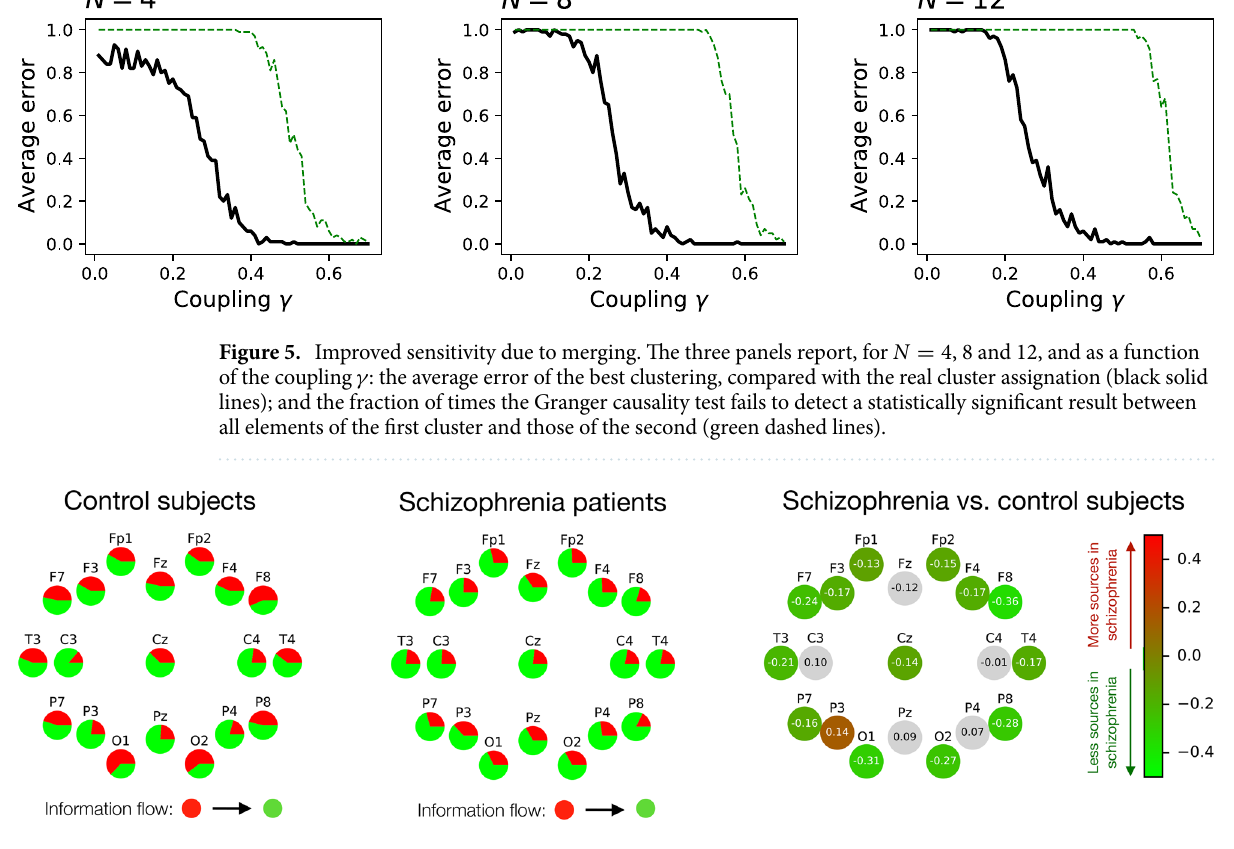
Figure 6. Causality clustering of EEG brain signals. The first two panels report the role of nodes (EEG sensors) for control subjects (left) and Schizophrenia patients (center). The red (green) part of each node represents the fraction of times that node has been classified in cluster 1 (respectively, 2), hence being a source (respectively, a sink) of information. The right panel represents the difference between Schizophrenia patients and control subjects, with green shades indicating nodes that are less frequently sources of information in patients. Grey nodes indicate no statistically significant differences between both groups at α = 0.01